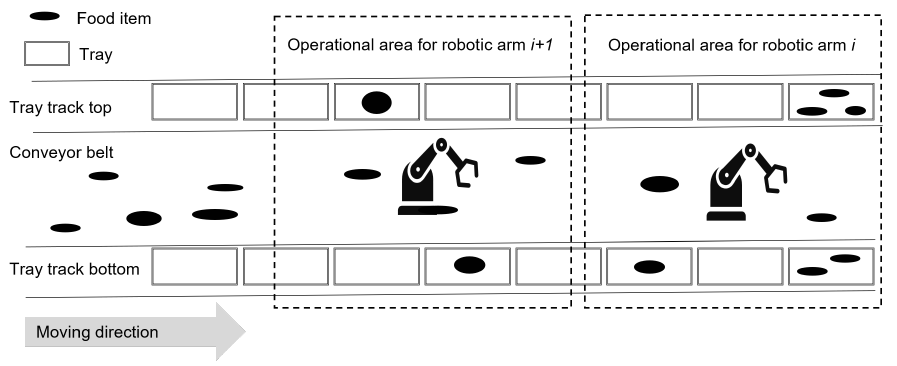
Figure 2. An illustration of a robotic arm batching